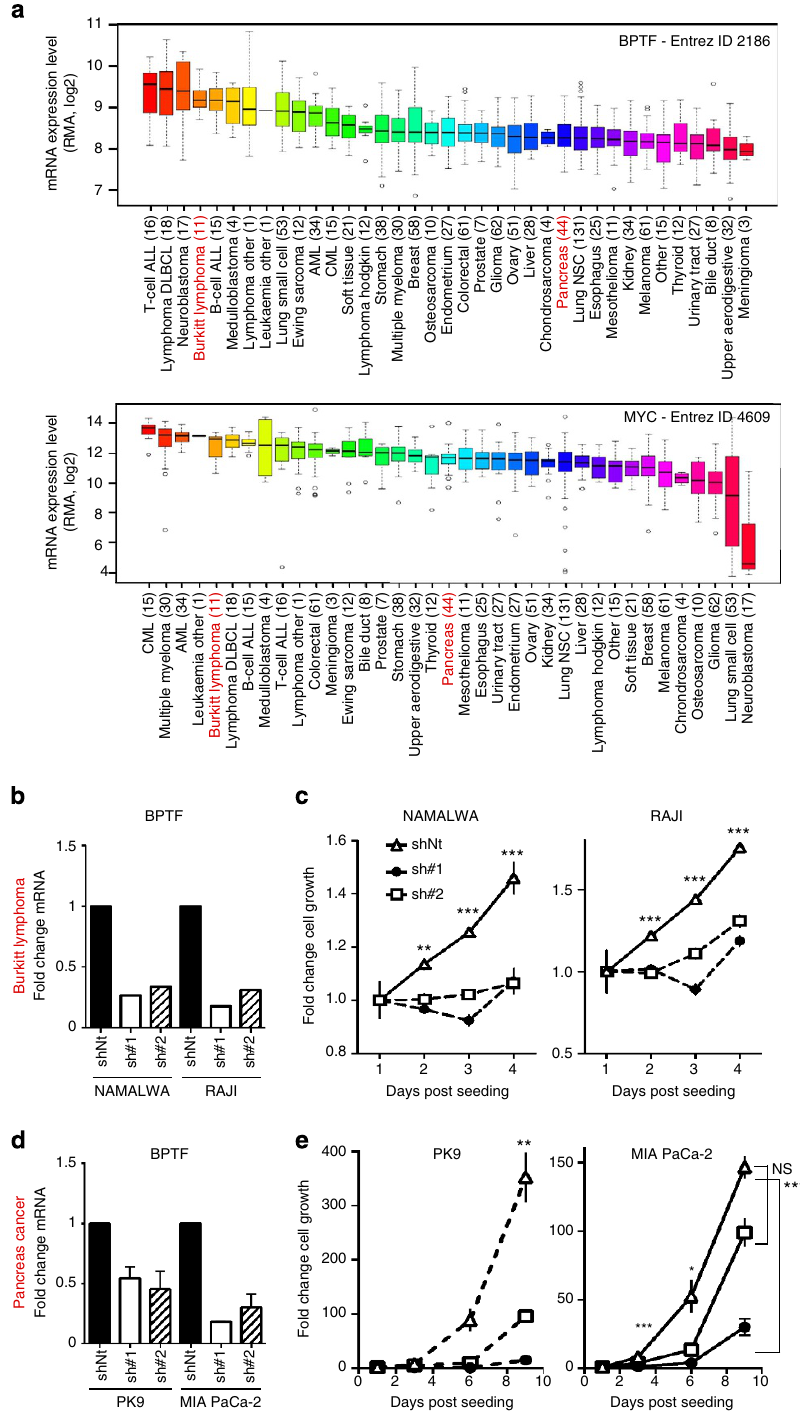
Figure 6 | BPTF knockdown suppresses the proliferation of BL and pancreatic cancer cells. ( a ) Top: box plot showing the relative BPTF mRNA levels across the different tumour types, extracted from CCLE_Expression_Entrez_ID_2186, with gene-centric robust multiarray analysis-normalized mRNA expression data. Bottom: box plot showing the relative c-MYC mRNA levels across a panel of human cell lines, extracted from CCLE_Expression_Entrez_ID_4609. The number of cell lines of each tumour type analysed is indicated in parentheses. Effective knockdown of BPTF in BL cells ( b ) and pancreatic cancer cells ( d ), assessed by RT–qPCR. Transcript levels were normalized against GAPDH and the sh-control samples. Proliferation analysis of two BL cell lines (NAMALWA and RAJI; c ) and two pancreatic cancer cell lines ( d ) transduced with either control (shNt) or BPTF-targeting shRNAs (sh#1 and #2) ( n ¼ 5). * P o 0.05; ** P o 0.01; *** P o